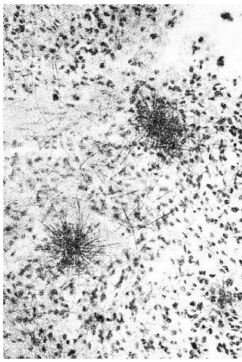
Figure 5. Distribution of 14 C in the intracellular space of the leaf of Zea mays L., 1753 [44].